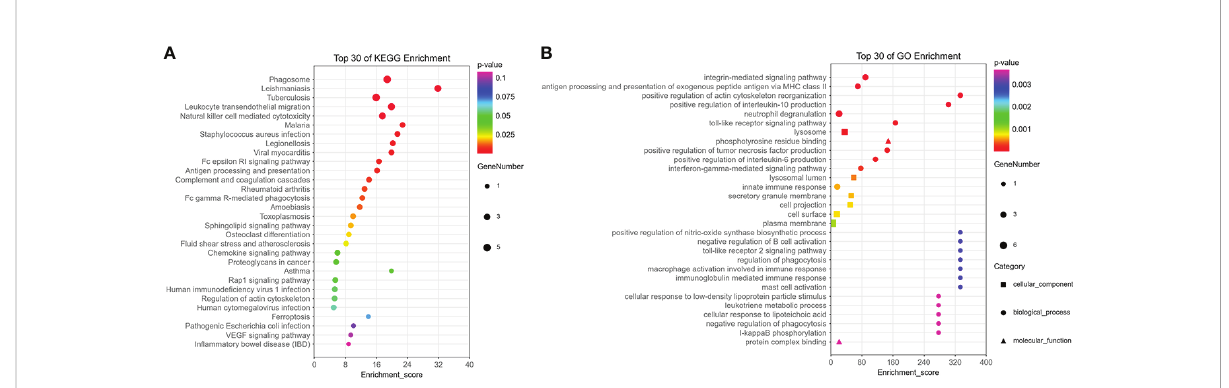
FIGURE 6 The enrichment analysis of 15 hub genes in the brown module. (A) The KEGG enrichment analysis of 15 hub genes in the brown module. (B) The GO enrichment analysis of 15 hub genes in the brown module, including cellular component, biological process, and molecular function.